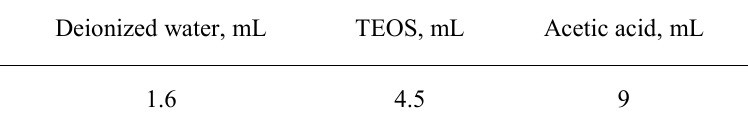
Table 1. Synthesis of samples according to sol-gel general